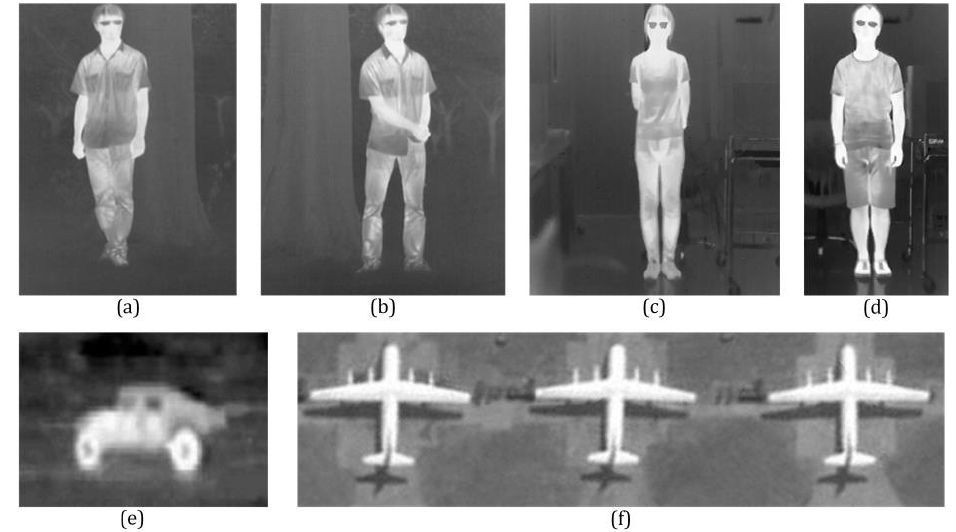
Figure 5. IR images used to make sensitivity analysis: ( a – d ) humans; ( e , f ) vehicles.